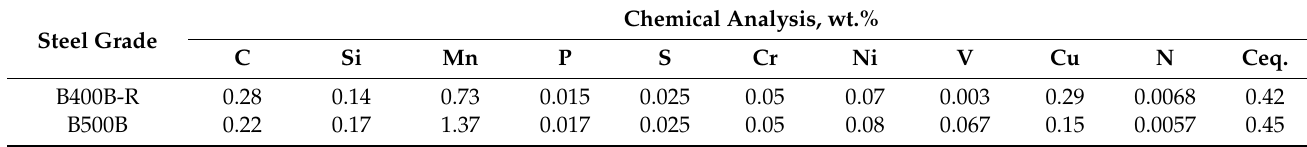
Table 1. Chemical composition of used steels rebars.